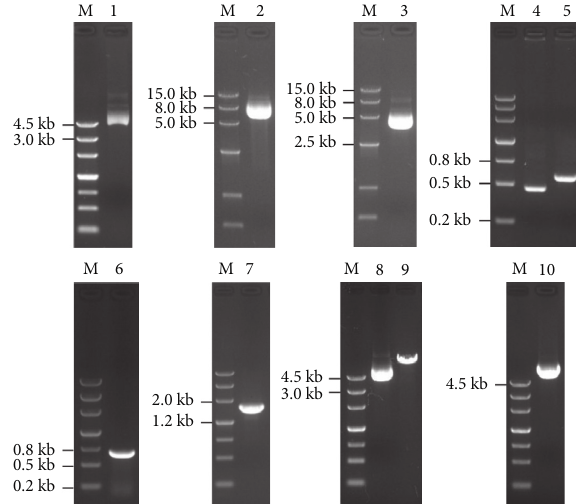
Figure 3: Construction of the binary vector pCAMBIA0390-Bar. M:DNA marker; lane 1: vector pAg1-H3; lane 2: vector pCAMBIA3301; lane 3: vector pCAMBIA0390; lane 4: promoter P trpC ; lane 5: bar gene; lane 6: terminator T trpC ; lane 7: bar gene expression cassette; lane 8: vector pCAMBIA0390; lane 9: linear vector pCAMBIA0390; lane 10: binary vector